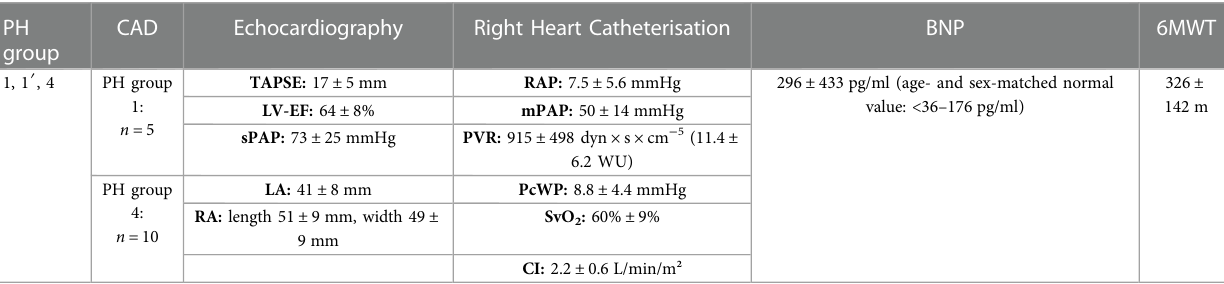
TABLE 1 Group 1 baseline values.